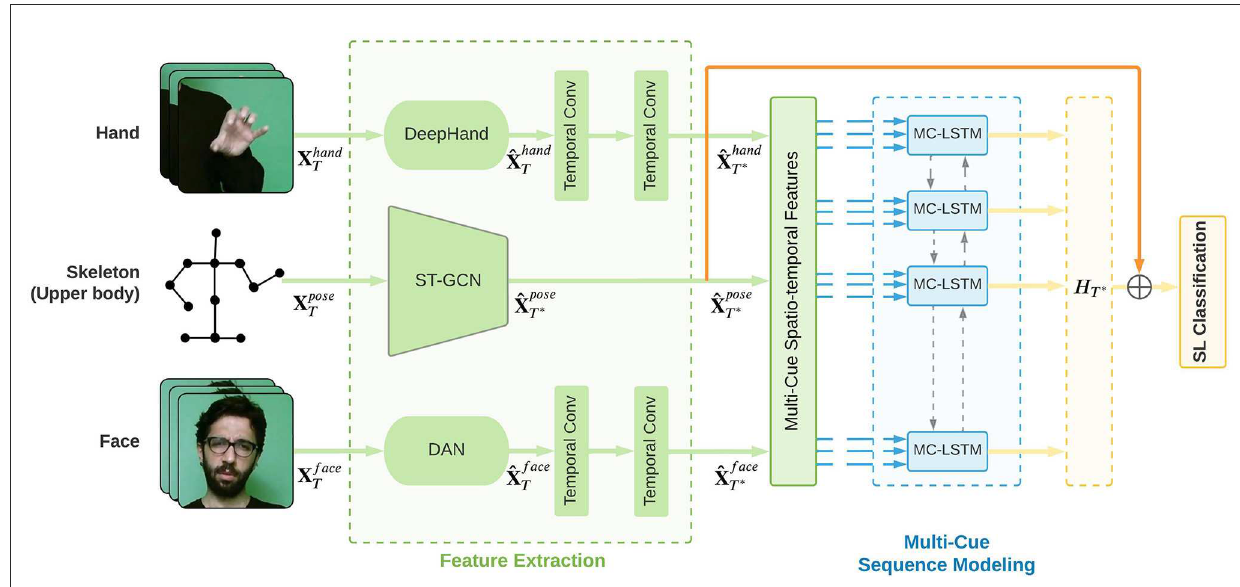
FIGURE2 Overview of our proposed multi-cue SLR architecture. ST-GCN and temporal convolutional layers are trained jointly with MC-LSTM, where cue-specific and cross-cue parameters are learned.